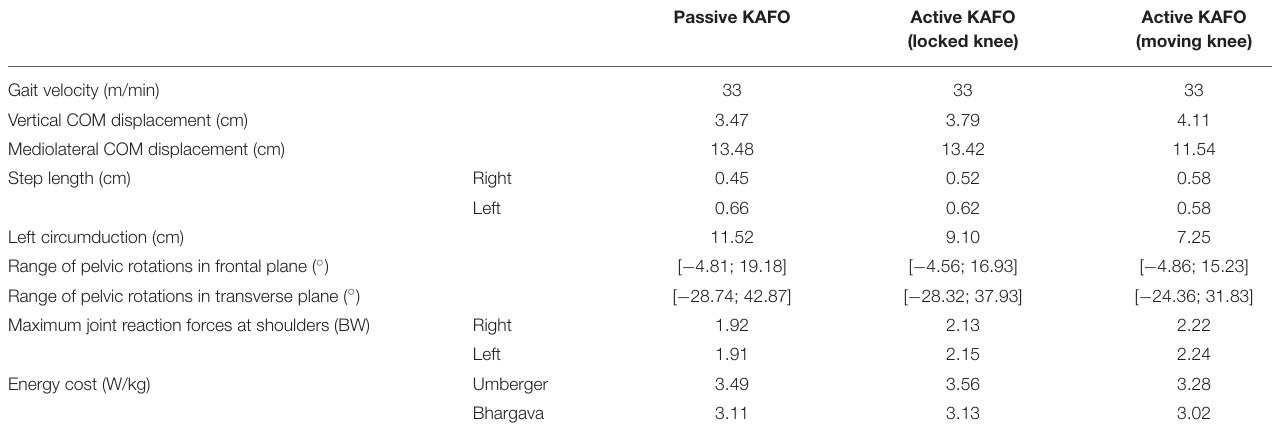
TABLE 1 | Comparison of obtained results with the three gait-assistive